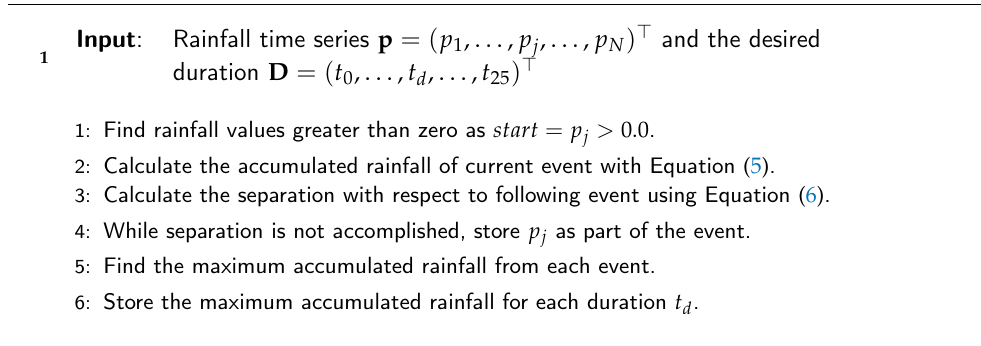
Algorithm 2: Sliding window algorithm for capturing maximum rainfall events